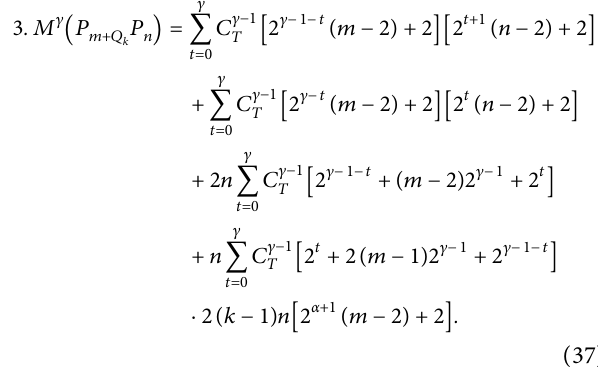
Figure 5: Numerical behavior of M c ( P